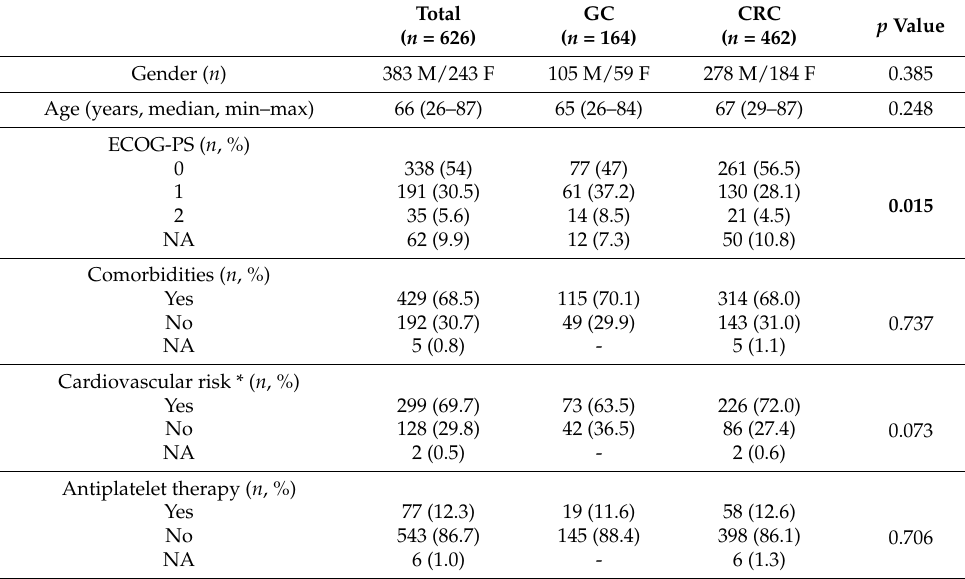
Table 1. Characteristics of all GI patients and according to tumor site (GC vs.